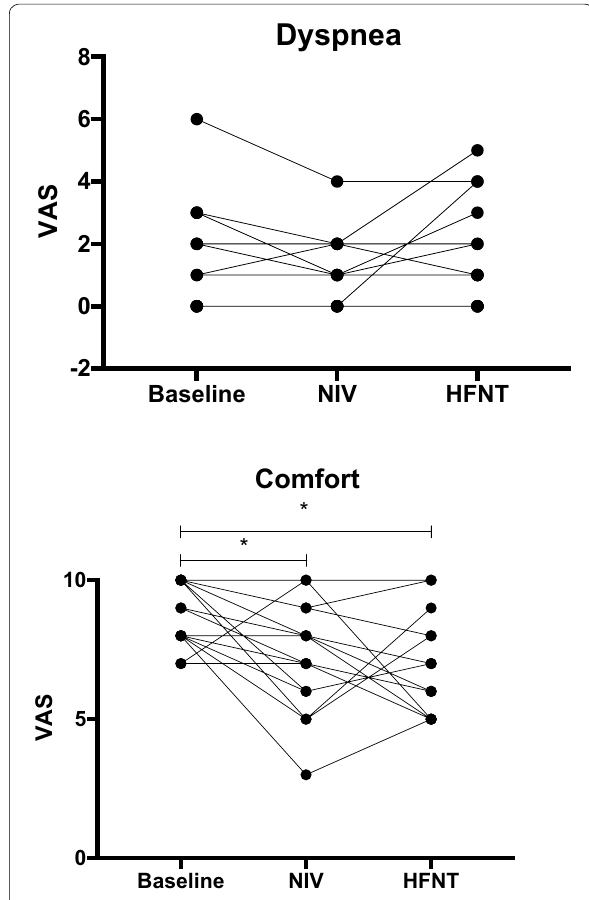
Fig. 4 Individual patient changes in symptom scores, n 15, = with some symptom scores overlapping. a Dyspnea scores were unchanged between baseline conditions and the use of either HFNT or NIV. b Compared to baseline conditions, both NIV and HFNT reduced comfort scores, * p < 0.05 (versus baseline), HFNT high-flow nasal therapy, NIV noninvasive ventilation. Dyspnea and comfort scores: (dyspnea: 0 no dyspnea, 10 maximal dyspnea. Comfort: = = 0 maximal discomfort, 10 very comfortable), n = = =